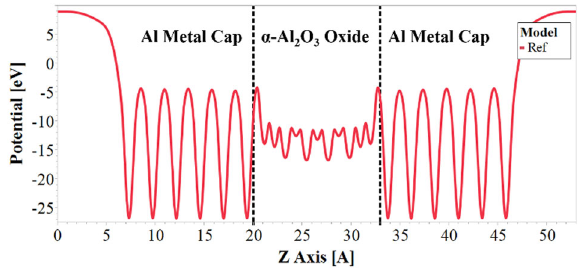
Fig. 2 The potential for the charge carriers along the z axis in the reference JJ Al/Al 2 O 3 /Al structure. The vertical dashed black lines indicate the interfaces